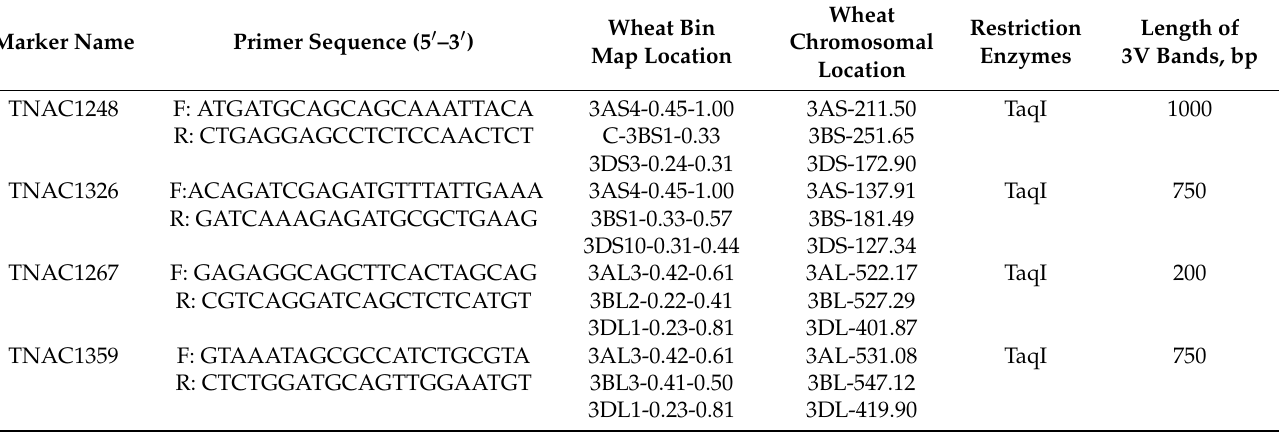
Table 1. PLUG primers belonging to Triticeae homoeologous Group 3 used in the study.